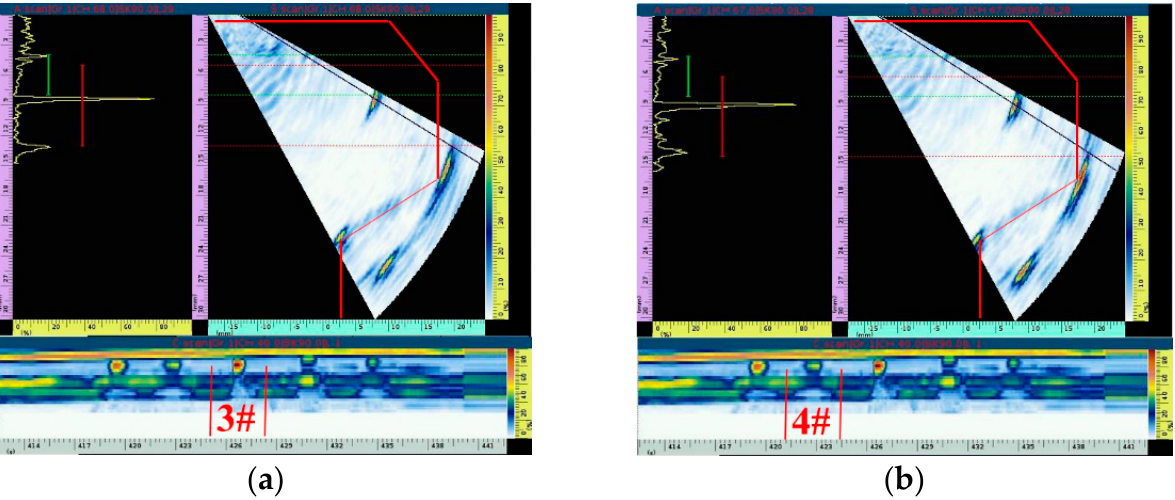
Figure 16. Signal echo analysis of slag inclusion and porosity defects. ( a ) Defect 3#. ( b ) Defect 4#.